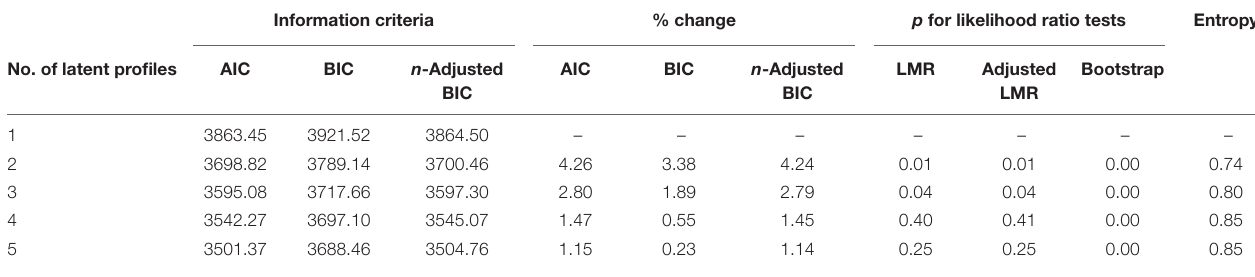
TABLE 5 | LPA model fit indicators (primary